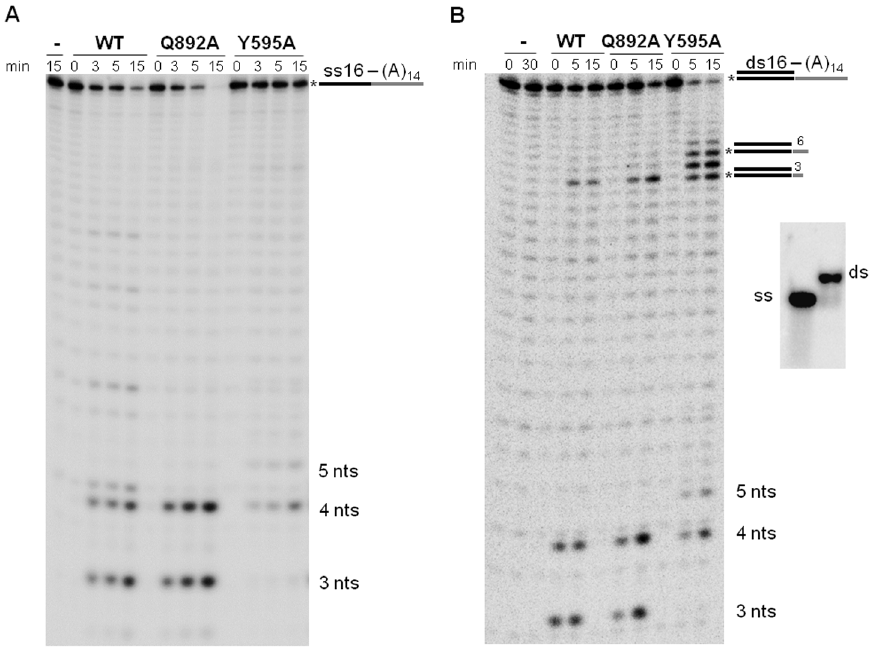
Figure 1. Exoribonuclease activity of Rrp44 and mutant versions of Rrp44. Activity assays were performed as described in Materials and Methods using 20 nM of enzyme (WT, Q892A and Y595A) and different substrates. Reactions were stopped and samples were taken at the time- points indicated. Length of substrates and degradation products are indicated in the figure. In panel A, 30-mer 5 9 -radioactively labeled RNA substrate (5 9 -CCCGACACCAACCACUAAAAAAAAAAAAAA-3 9 ) was supplemented with 40 nM of substrate nonlabeled. In panel B, 30-mer 5 9 -radioactively labeled RNA substrate (5 9 -CCCGACACCAACCACUAAAAAAAAAAAAAA-3 9 ) was annealed with a RNA oligonucleotide (5 9 -AGUGGUUGGUGUCGGG-3 9 ). Figure on the right side depicts the control of the annealing of the double-stranded (ds) substrate on a native polyacrylamide gel.